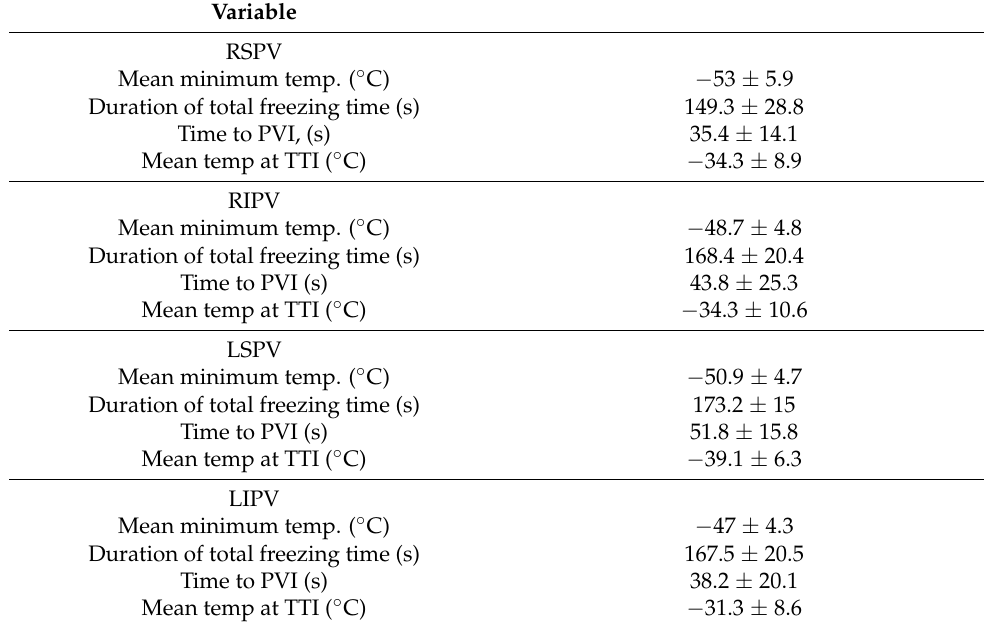
Table 3. Procedural details—individual pulmonary veins. Values are expressed as n (%) or mean ± standard deviation. PVI, pulmonary vein isolation; RSPV, right superior pulmonary vein; RIPV, right inferior pulmonary vein; LSPV, left superior pulmonary vein; LIPV, left inferior pulmonary vein; LCPV, left common pulmonary vein; temp., temperature; TTI,